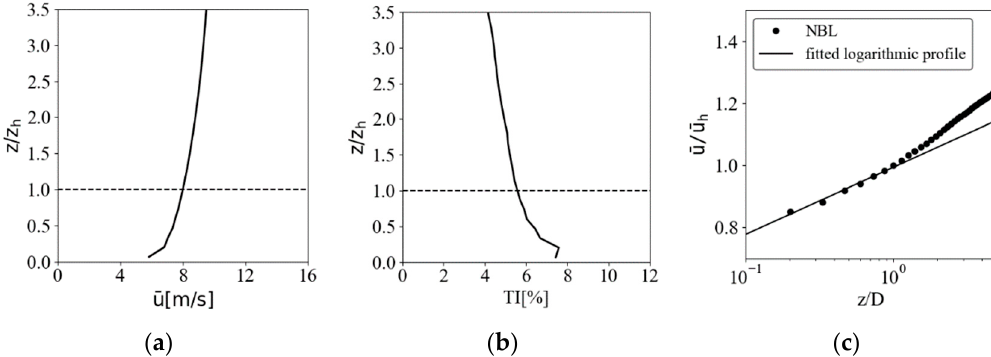
Figure 3. Main features of the incoming flow: vertical profiles of ( a ) the normalized streamwise inflow velocity and ( b ) the streamwise turbulence intensity. The horizontal dashed line indicates the hub height level; ( c ) vertical profile of the normalized streamwise inflow velocity on a semi-log scale. The black solid line represents perfect law-of-the-wall scaling.